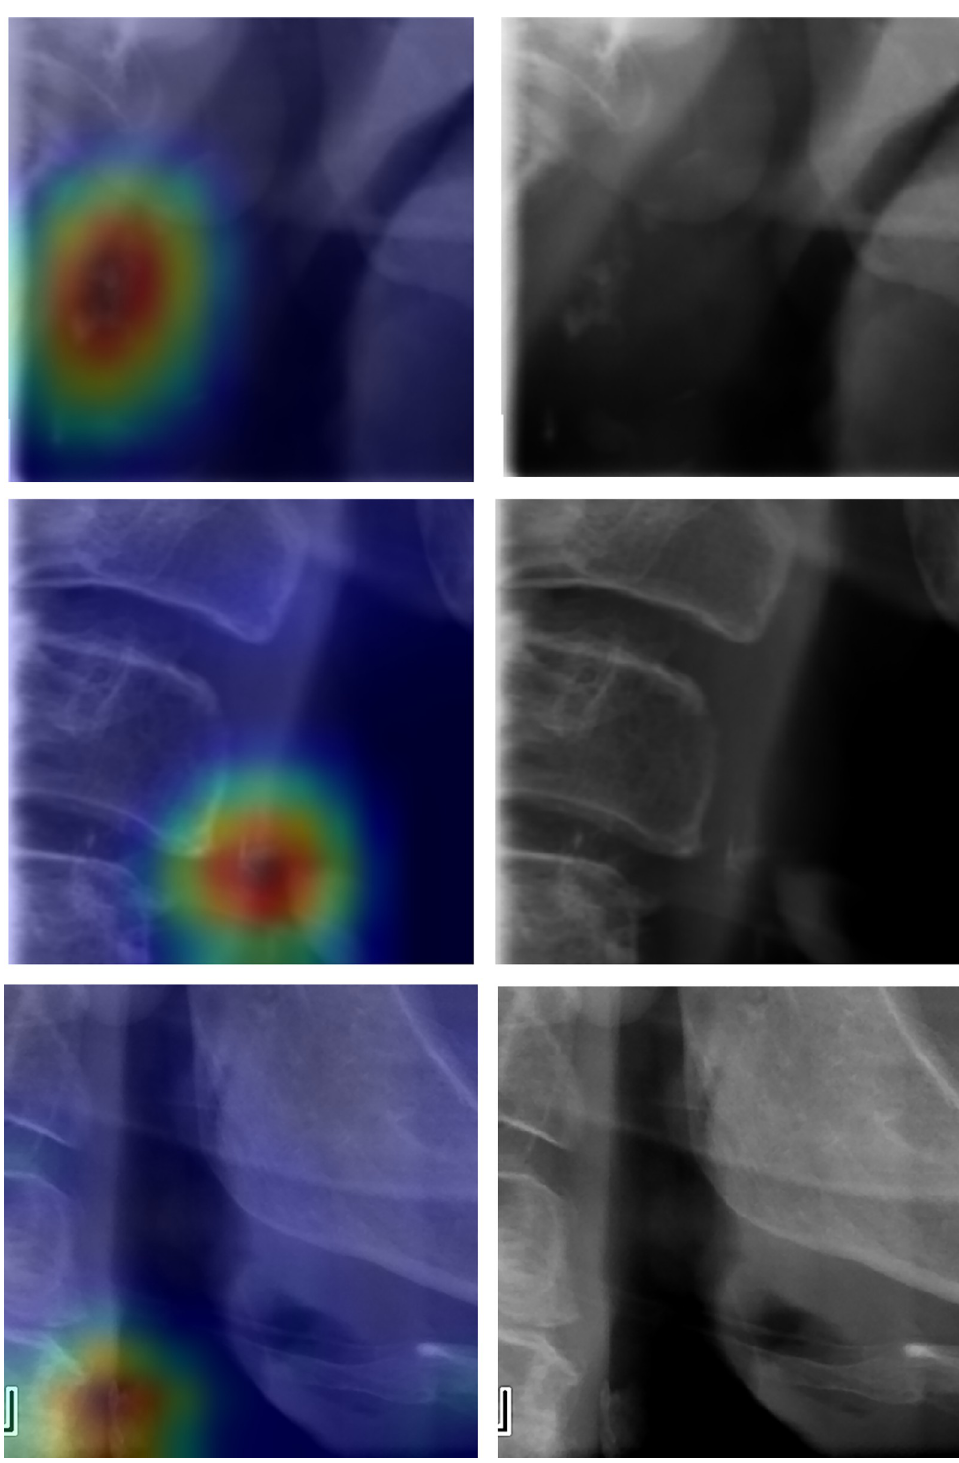
Fig 3. Gradient-weighted class activation mapping (Grad-CAM) of a correct prediction of CAC and “clean” classes. The colors indicate the region that has the greatest impact on the CAC prediction. The color range is presented below (ranging from red, representing the regions with the greatest impact on the CAC prediction, to blue, representing the regions with the lowest impact). It can be noticed that the classifier indeed focused on the region of the calcification signs. Other Grad-CAM of CAC and clean predications can be found in the S3 Fig and S4 Fig.